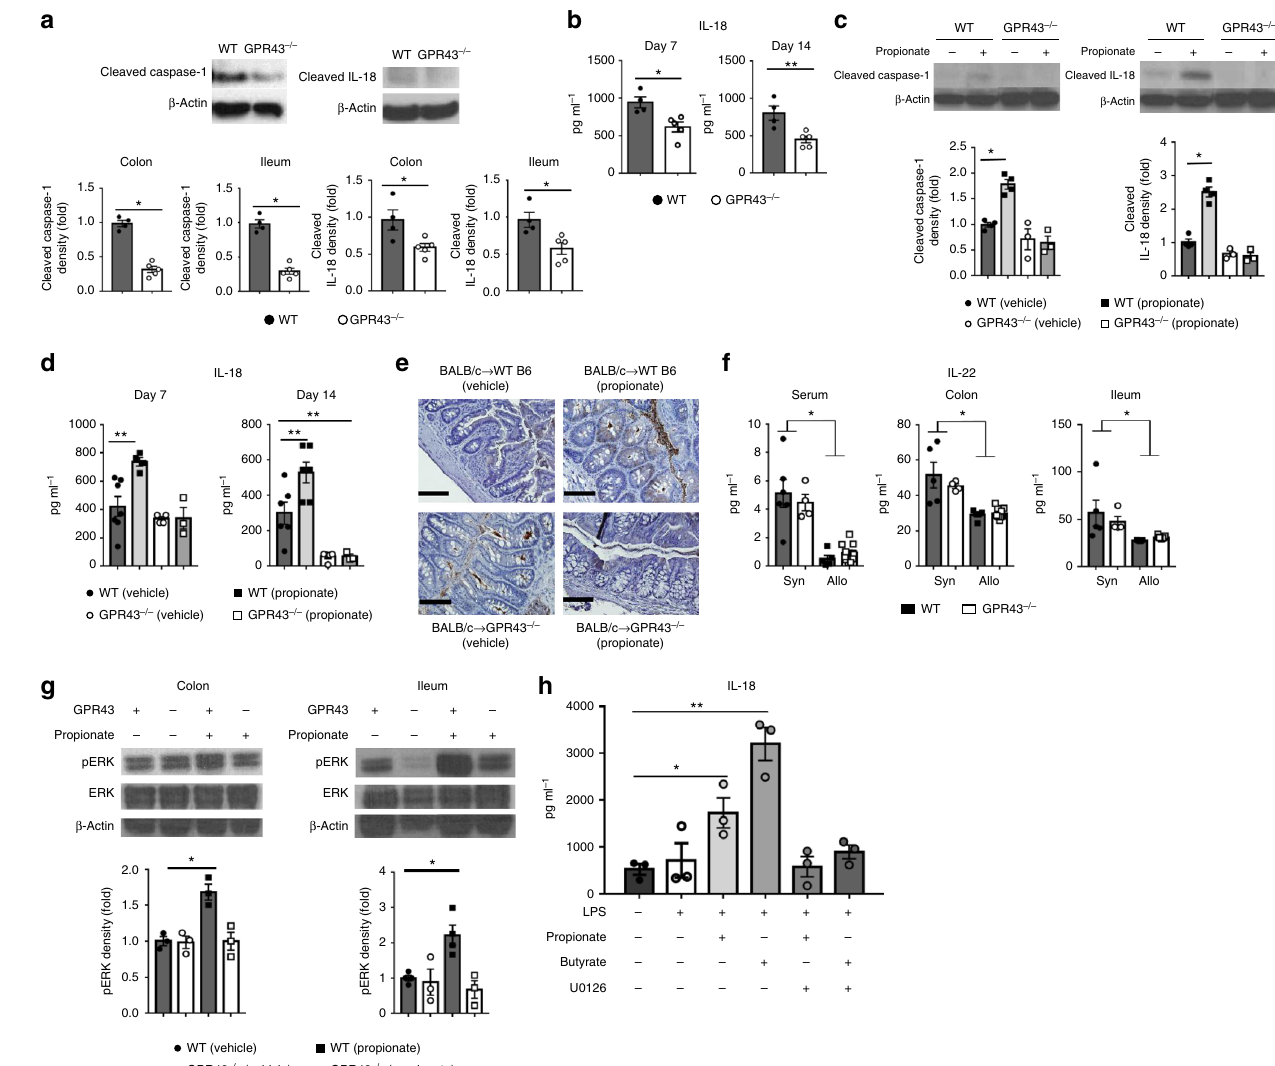
Fig. 5 SCFA-dependent GPR43 signaling confers GI GVHD protection through the ERK – NLRP3 pathway. B6 WT and Gpr43 − / − mice received BMT from syngeneic or allogeneic donors. a Representative immunoblots and densitometric analysis of cleaved caspase 1 and cleaved IL-18 normalized to the presence of β -actin in IECs (CD326 + ) from allogeneic recipients 14 days after BMT ( n = 4 – 5 each, two-tailed Mann – Whitney U test). b Serum IL-18 levels at day 7 and 14 after BMT ( n = 4 WT, n = 5 Gpr43 − / − , two-tailed unpaired t -test). c Representative immunoblots and densitometric analysis of